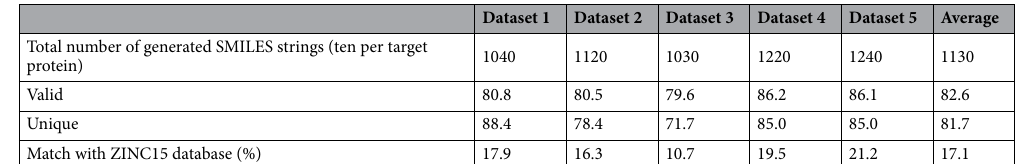
Table 3. Percentages of valid, unique and ZINC15 database-matched SMILES strings generated by the model in ten per one mode.